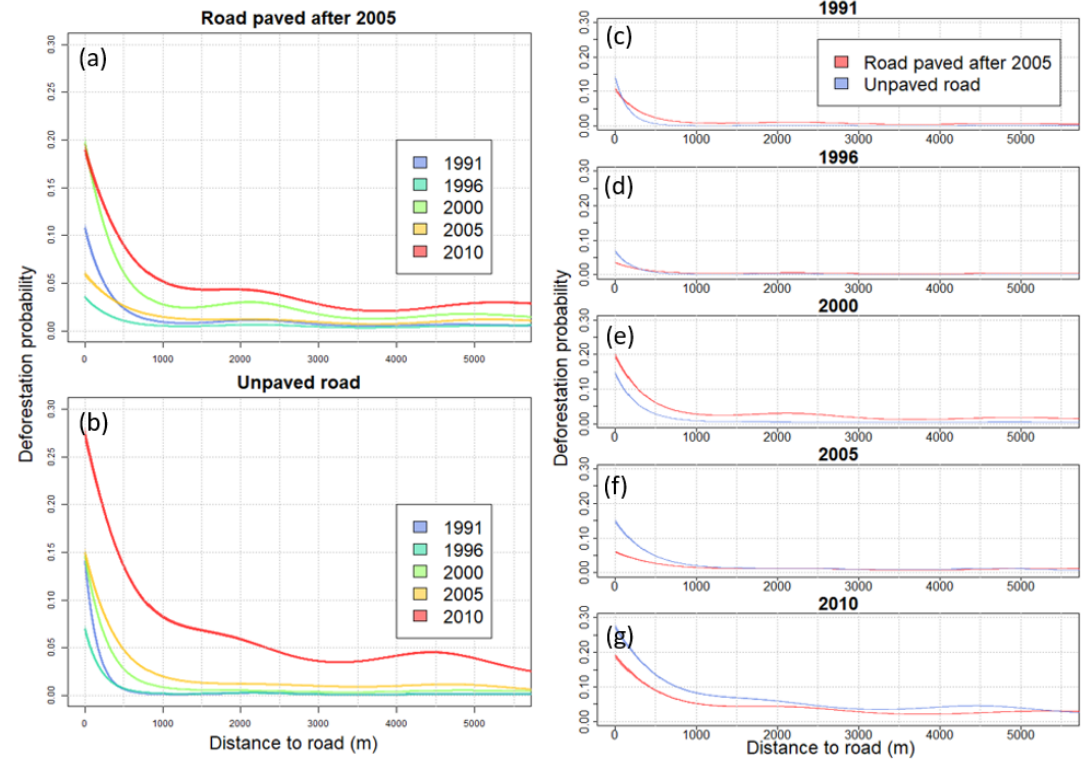
Figure 6. Proximity to roads increase deforestation probability, but this relationship varies substantially from year to year and from one road segment to another in the MAP frontier, southwestern Amazon. Panels ( a ) and ( b ) highlight temporal variability within each road segment while panels ( c )–( g ) compare both road segments within individual years. Separate GAM models were fitted to data containing 500,000 pixels for each year and each road segment. To depict the relationship between D Road and deforestation risk ˆ π it , we created a dataset in which we systematically varied D Road while keeping p i ( t − 1 ) and D Commun fixed to their mean values. We used this dataset, together with the unbiased intercept β − log 1 t = (cid:101) β and the estimated smooth functions, to calculate ˆ π it .